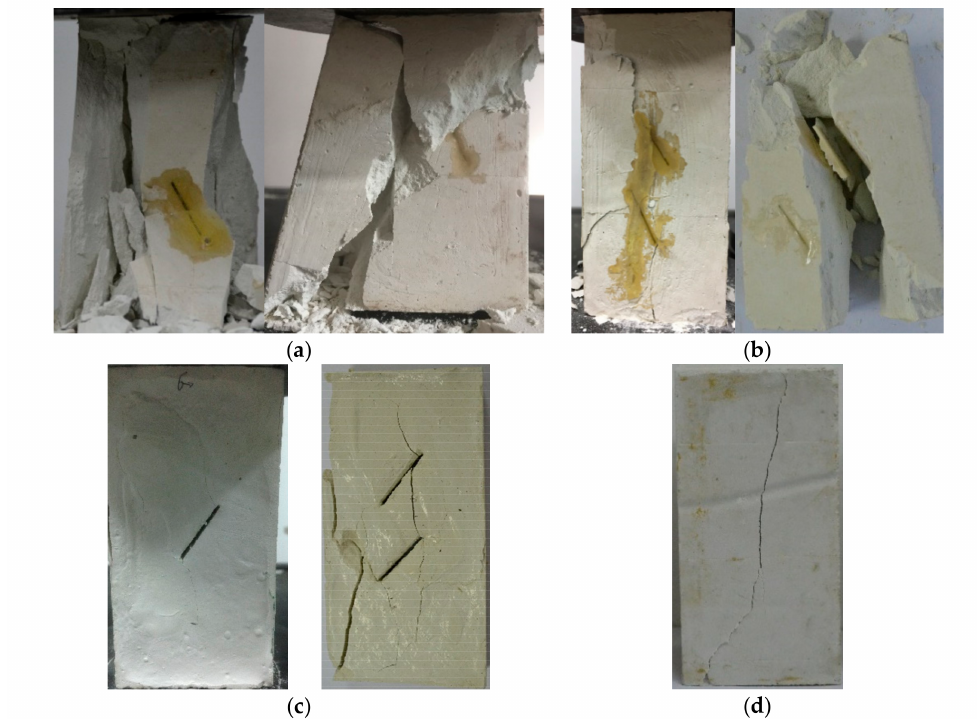
Figure 4. Failure diagram of specimen: ( a ) single-crack after grouting; ( b ) double-crack after grouting; ( c ) cracked specimens before grouting; and ( d ) without